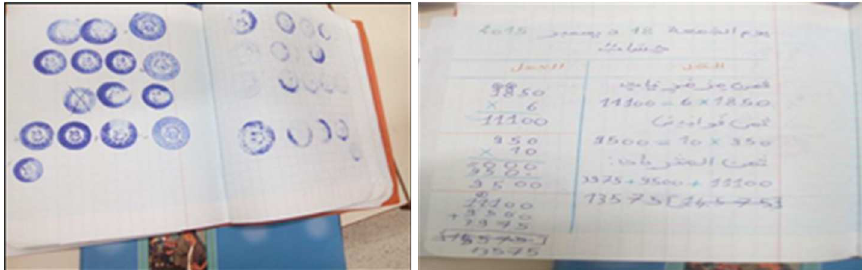
Tableau 6 : Les résultats du pré et du post-test de l’échantillon expérimental Fig. 11. Apprentissage de la manipulation de l’argent pour l’échantillon témoin. ( MT : Lire le temps ; MA : Manipuler l’argent dans des situations de la vie quotidienne ; EQ : Utiliser les outils et les unités de mesure des poids et des longueurs). Tableau 7 : Les résultats du pré et du post-test de l’échantillon témoin ( MT : Lire le temps ; MA : Manipuler l’argent dans des situations de la vie quotidienne ; EQ : Utiliser les outils et les unités de mesure des poids et des